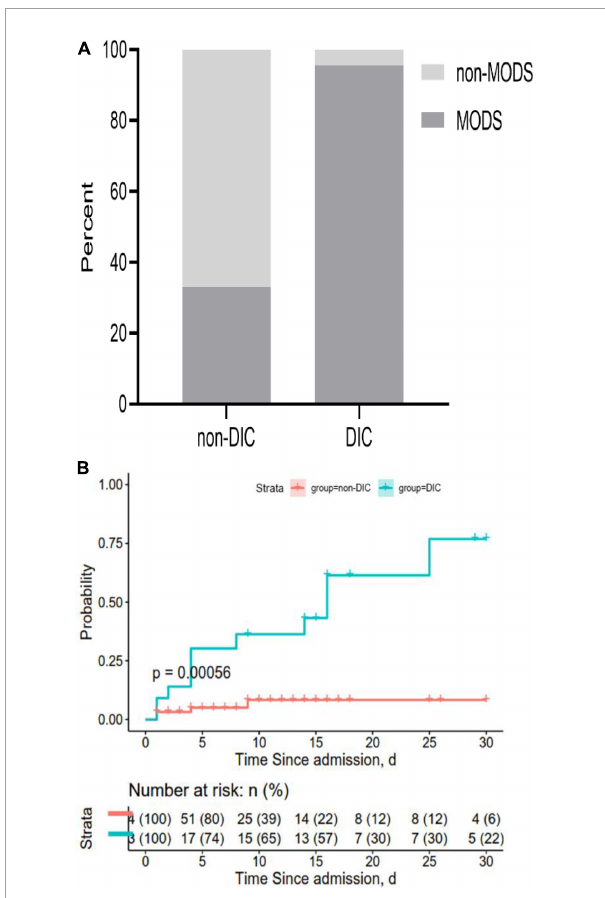
FIGURE7 Rates of (A) multiple-organ dysfunction syndrome (MODS) and (B) overall survival at 30 days after admission. Both panels show data for all 87 patients in the